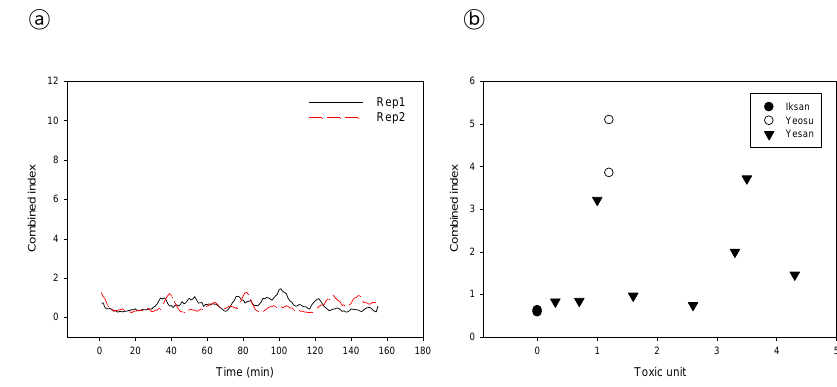
Figure 5. (a) Results of Iksan e ffl uent (0TU). Rep# refers replication number. (b) Result of Iksan, Yeosu, and Yesan e ffl